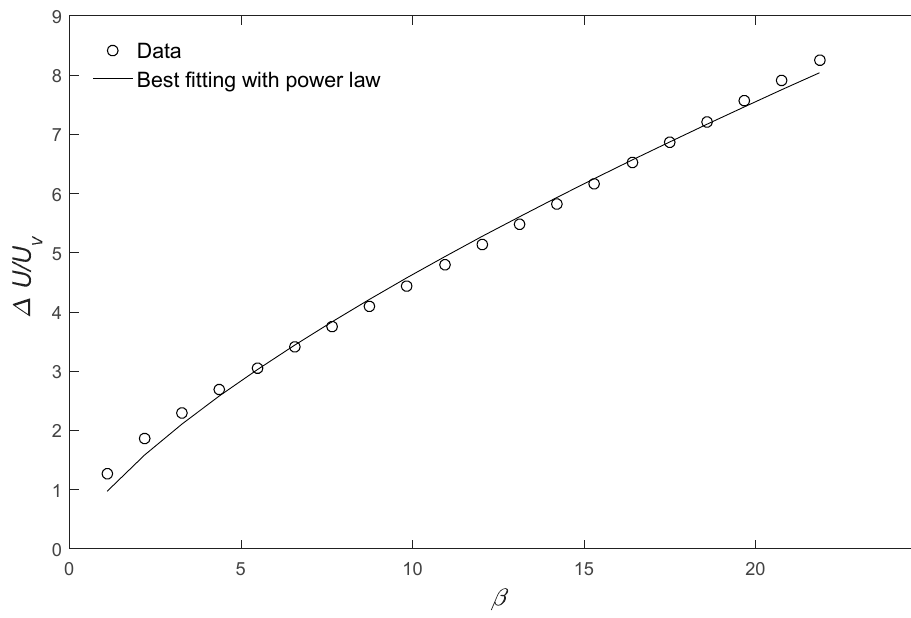
∆ U / U v and β from the numerical